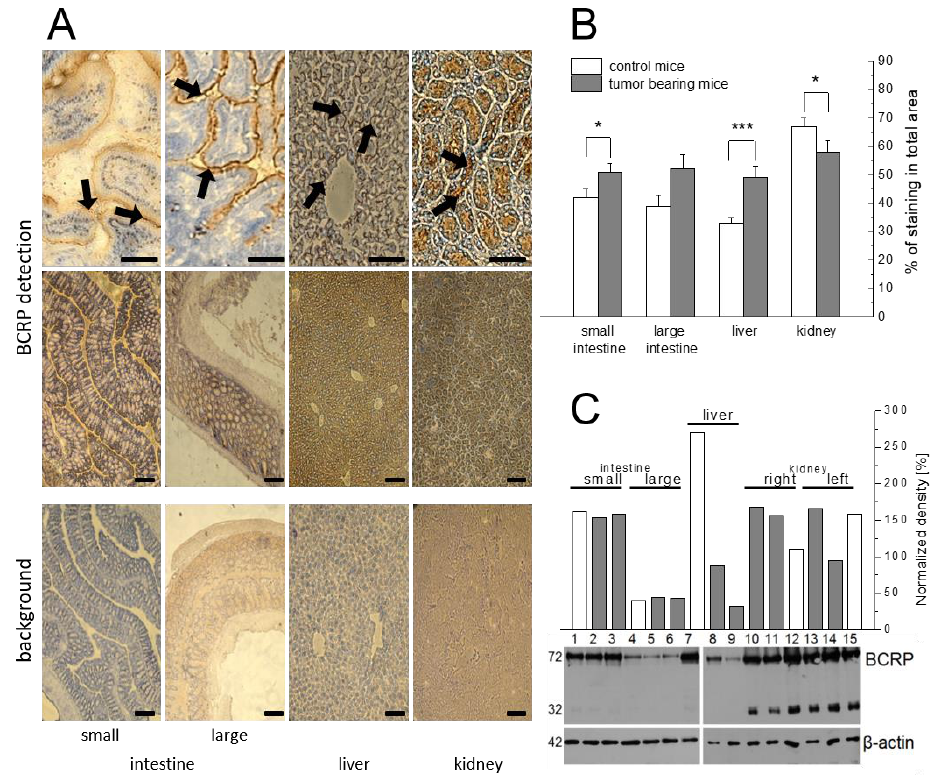
Figure 1. Immunohistochemical detection of BCRP in mouse normal tissues, distant from the tumor site: the assays were done on the small and large intestine, liver, and kidney tissues of DBA/2 mice bearing a S91 melanoma tumor at an advanced stage of growth (mass greater than 1 g; volume ≥1000 mm 3 ), using an anti-BCRP monoclonal antibody (BXP-53). ( A ) Microscopic images of tissue slices stained with an anti-mouse HRP-DAB antibody (BCRP in brown, stained areas indicated with black arrows) and counterstained with hematoxylin (blue). Background slices were processed without primary antibody (see the text for details). Scale bar: 5 µ m; ( B ) Quantitative analysis of BCRP-specific immunohistochemical staining of tissues from control mice and melanoma tumor-bearing mice at an advanced stage of growth. The graph shows the percentage of the stained area relative to the total area of the tissue slices (calculated as the surface of imposed binarization mask; see the text for details). The results are presented as a mean and standard error for the group of histological images. Statistical significance and sample size: small intestine: p = 0.053; n = 60, N = 6 in the control group and n = 20, N = 2 in the group of tumor-bearing mice; large intestine: * p < 0.05; n = 50, N = 5 in the control and n = 30, N = 3 for the group of tumor-bearing mice; liver: *** p < 0.001, n = 60, N = 6 in the group of mice with tumor; n = 30, N = 3 in the group of tumor-bearing mice; kidney: * statistical significance by t -test: p < 0.05, n = 60 (number of histological images analyzed), N = 6 (number of animals) in the control group and n = 40, N = 4 in the group of tumor-bearing mice; ( C ) The expression of BCRP in tissues from healthy and small-to-moderate melanoma tumor-bearing mice, estimated using Western blotting, using the BXP-53 antibody. In C, top, bars represent the mean values from duplicates (standard error does not apply) of the densitometric signal obtained by visualizing the blots, as normalized to β -actin level. Images were analyzed using the software Image-J (see the text for details). In C, bottom, a representative Western blot showing BCRP level in the tissues of healthy and tumor-bearing mice, visualized with a luminol and exposed to photographic film. Lane and bar designation: 1–3—the small intestine; 4–6—the large intestine; 7–9—liver; 10–12—right kidney; 13–15—left kidney; 1, 4, 9, 12, and 15—tissues from healthy mouse (control); 2, 3, 5–8, 10, 11, 13 and 14—tissues from tumor-bearing